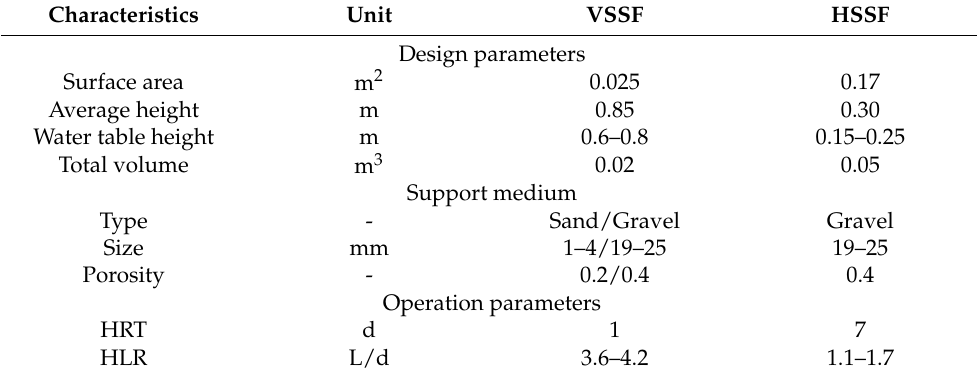
Table 1. Main characteristics of a hybrid constructed wetland.